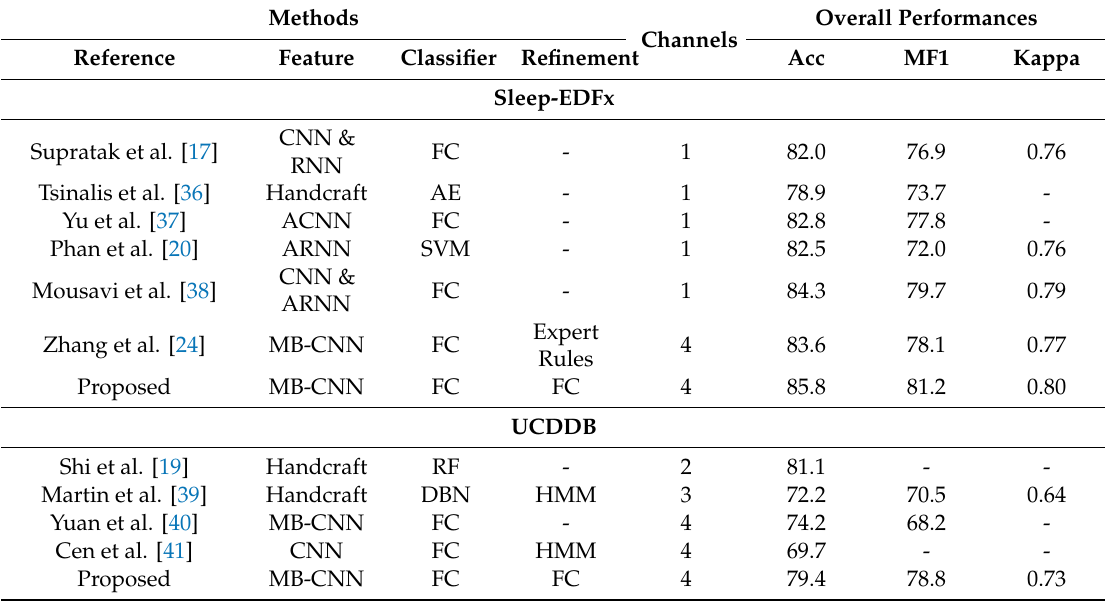
Table 5. Performance of di ff erent methods on the Sleep-EDFx and UCDDB